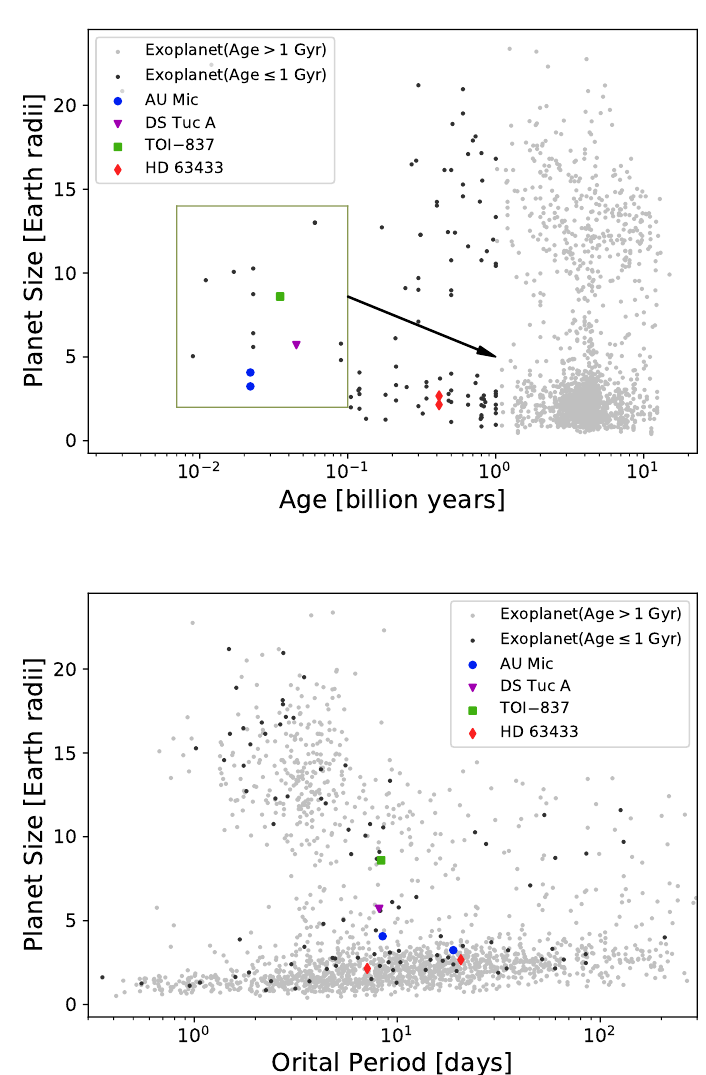
Figure 11. The distribution of young planets from this study. Top panel : Planet radii versus ages. Bottom panel : Planet radii versus orbital periods. We also show known planets from the NASA exoplanet archive for comparison. The ages, radii and periods are taken from the NASA Exoplanet Archive on 3 October 2022. The known planets with ages greater or smaller than 1 Gyr are marked using grey and black dots respectively. To minimize the influence of outliers, our selection of known planet sample has been restricted to those with a fractional radii measurement error of less than